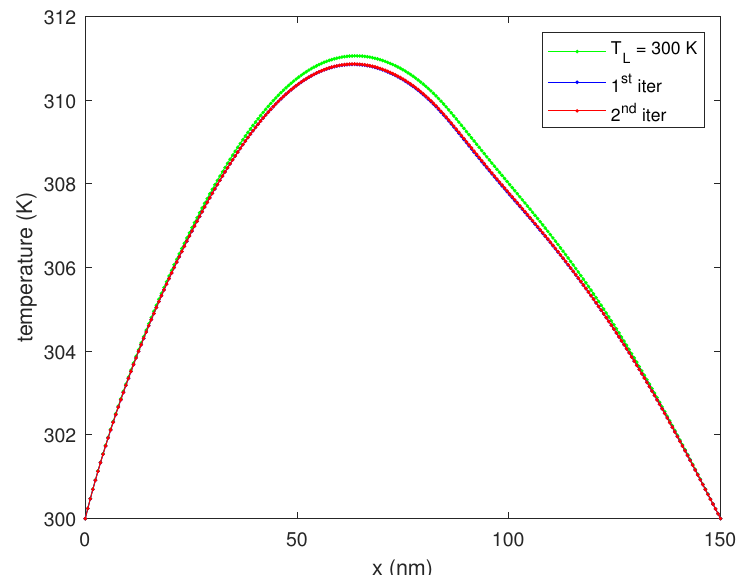
Figure 9. The lattice temperature T L versus position for some iterations, for V b = 1.6